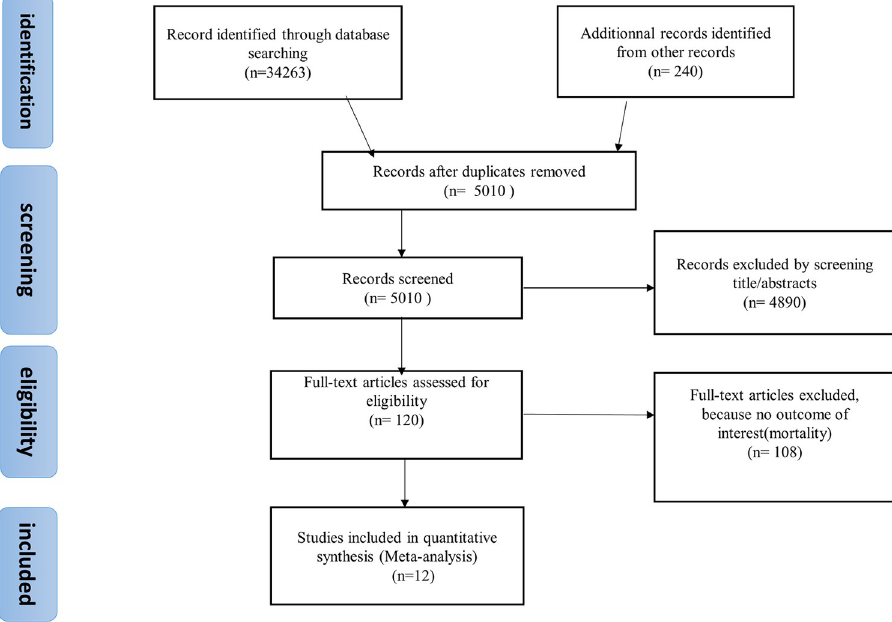
Fig 1. Flowchart showing the selection of studies for the meta-analysis of the association of diabetes mellitus with COVID-19 mortality in sub-Saharan Africa.